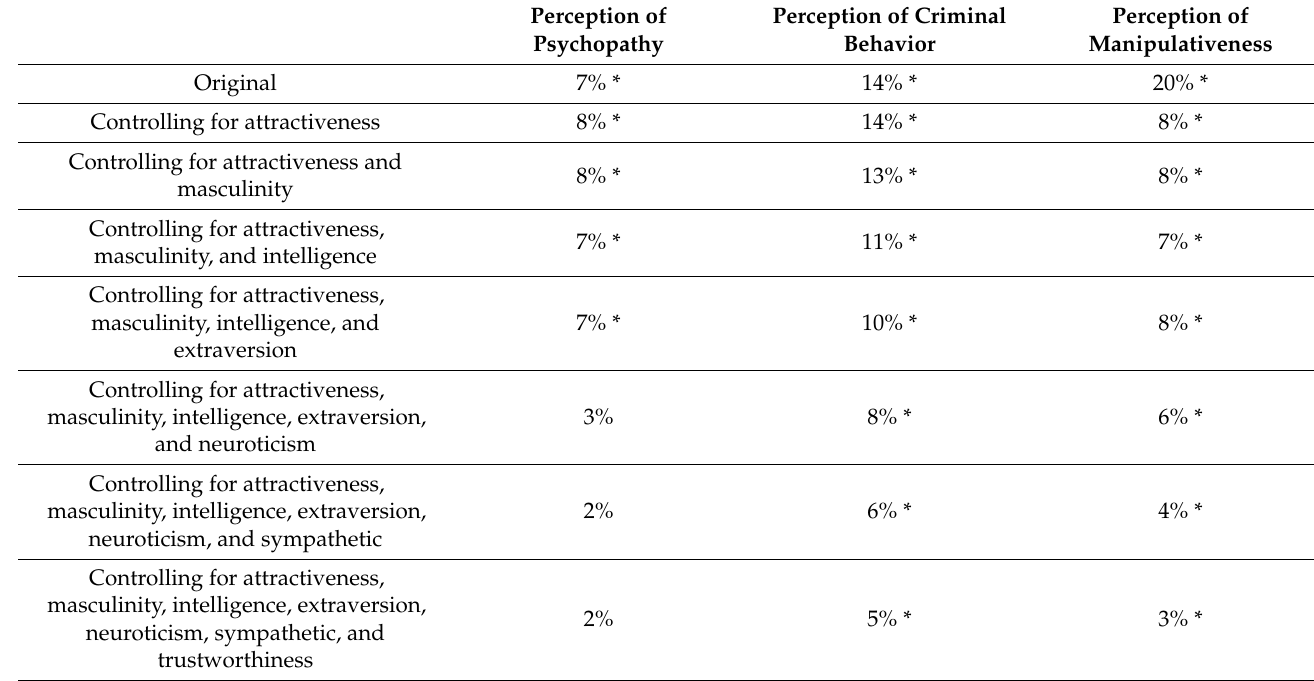
Table 4. Study 2: Social Relations Analysis of psychopathic traits after iteratively controlling for halo effects: Percent of variance attributable to the